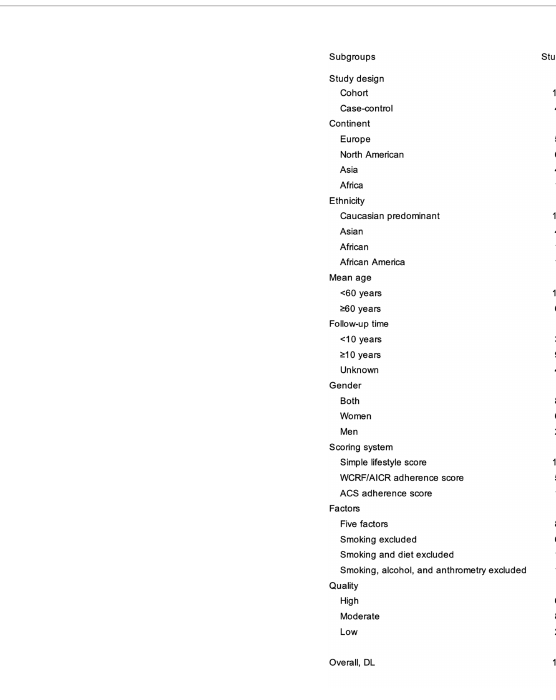
FIGURE 4 | The results of the subgroup analyses for risk of